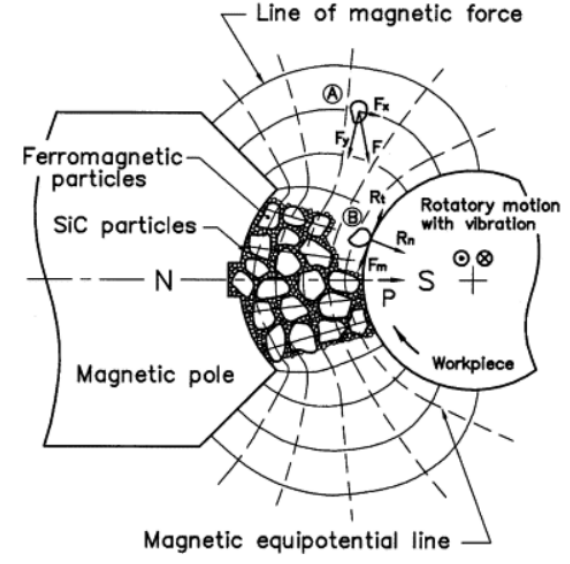
Figure 53. The magnetic forces that act in the X and Y directions on abrasive particles [256].